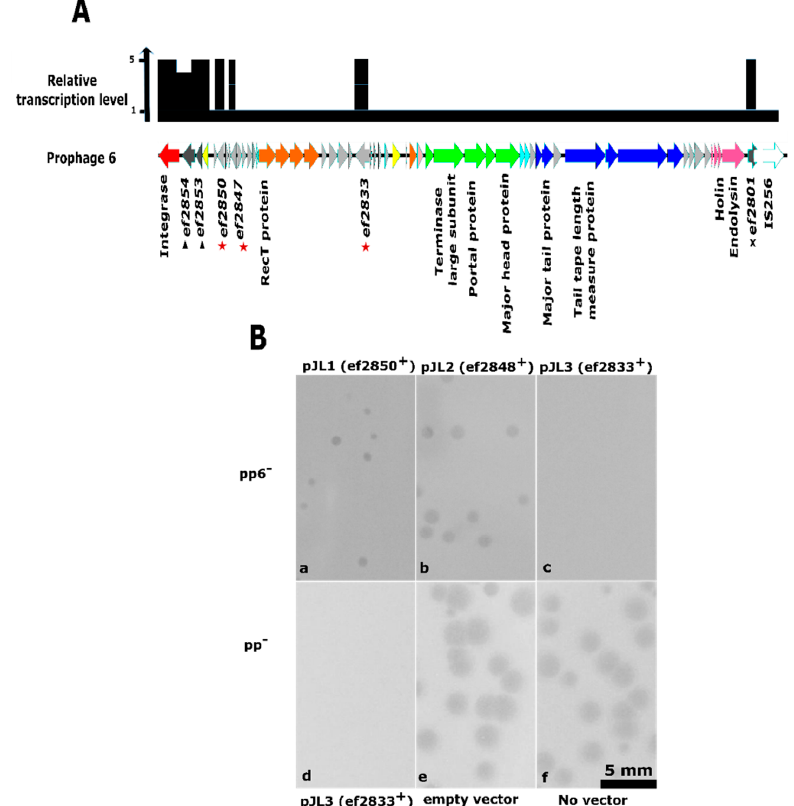
Figure 4. Identification of the V583 endogenous prophage 6 (pp6) gene responsible for Idefix resistance. ( A ) Genomic organization of pp6 and relative transcription level of each gene. The genomic organization of pp6 is modified from [43]. Gene functions are color-coded and detailed wherever possible (red: integrase, yellow: transcriptional regulation, orange: DNA metabolism, green: DNA packaging and head, light blue: head to tail, dark blue: tail, fuchsia: lysis, grey: hypothetical proteins, white: transposable element). Relative transcriptional level of each gene is indicated in black and designed from a previously published transcriptomic study [48]. Eight pp6 genes are constitutively expressed during V583 normal growth conditions. Among those not involved in pp6 lysogenic decision: a membrane protein and putative metallo-peptidase genes are indicated with triangles, a putative glycosyltransferase gene disrupted by a transposable element is indicated with a cross and the three other genes tested as abi candidates are indicated with red stars. ( B ) Interference with Idefix infection following the expression of the three pp6 abi candidates, plaque assays performed on strain pp6 − (A to C) or pp − (D to F) transformed by: a. pJL1. b. pJL2. c. pJL3. d. pJL3. e. the pJIM2246 empty vector.